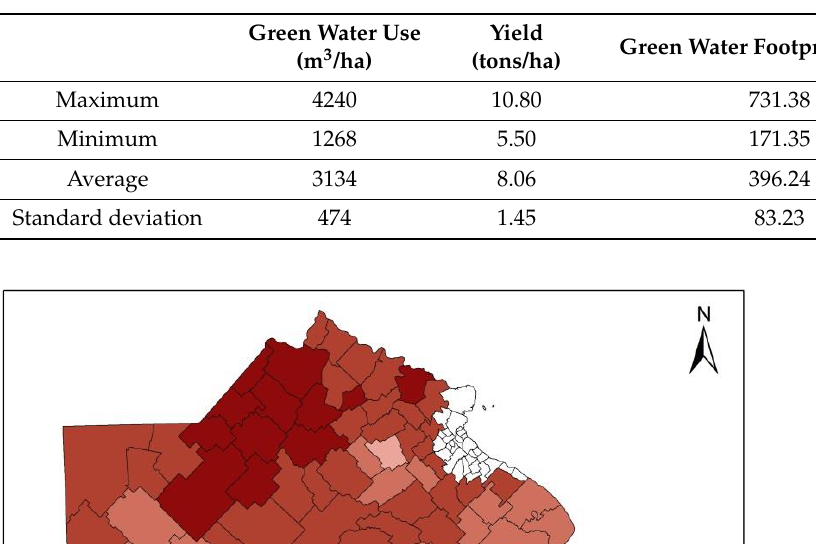
Table 2. Statistical data of green water use, yield, and green water footprint in the province of Buenos Aires.